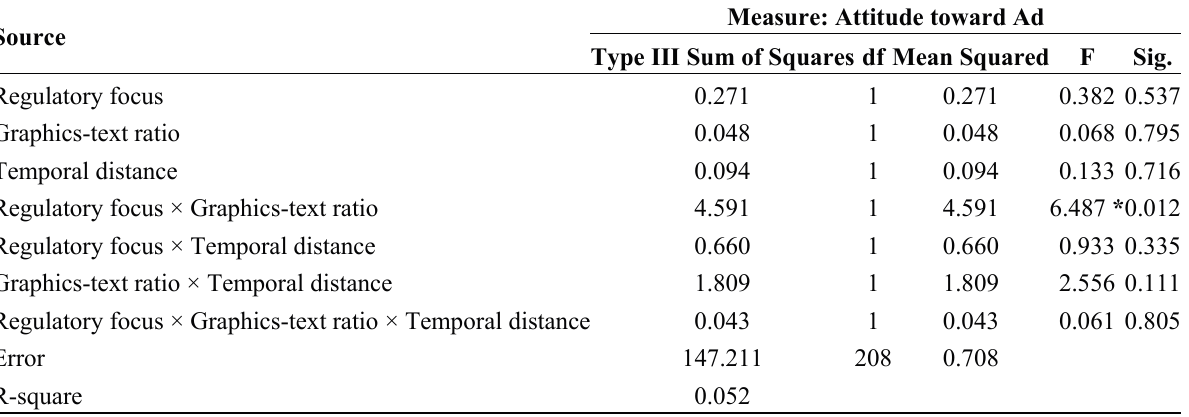
Table 4. Tests of between-subject effects for attitude toward advertisment.